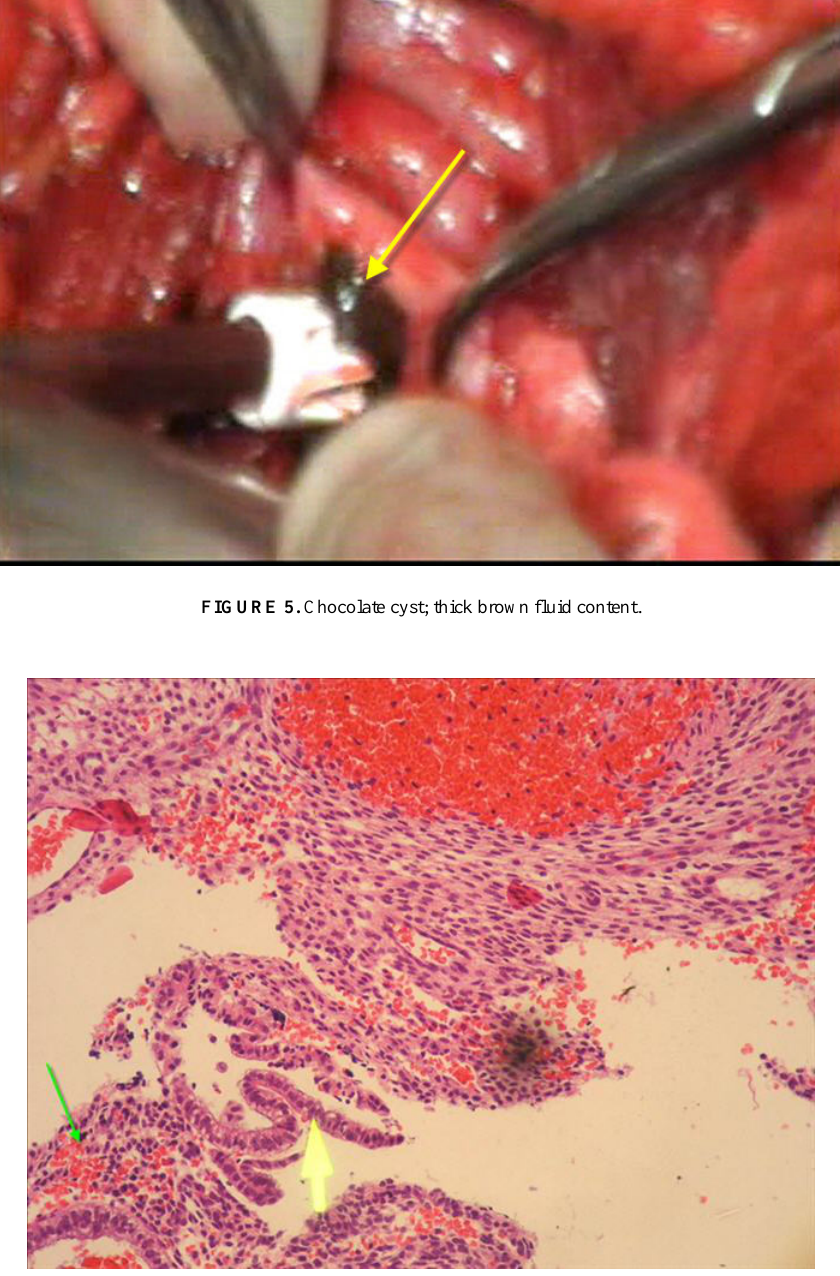
ureteric involvement in endometriosis should be suspected in patients who complain of suprapubic or flank pain, frequency, urgency, dysuria, or hematuria. Ureteric involvement is uncommon, most of